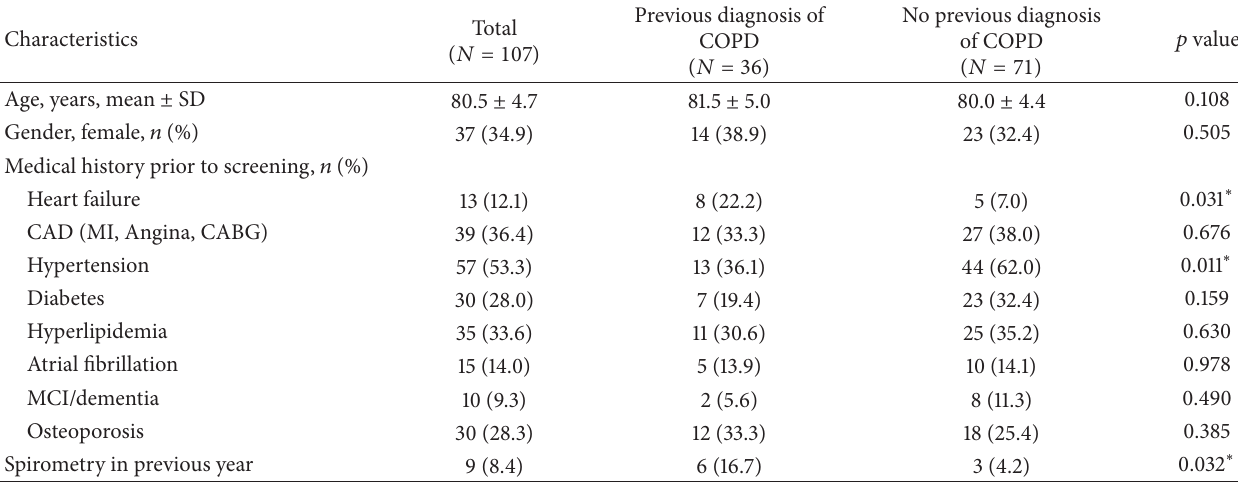
Table 2: Characteristics of patients with a 20-pack-year history of smoking ( 𝑁 = 107 ).